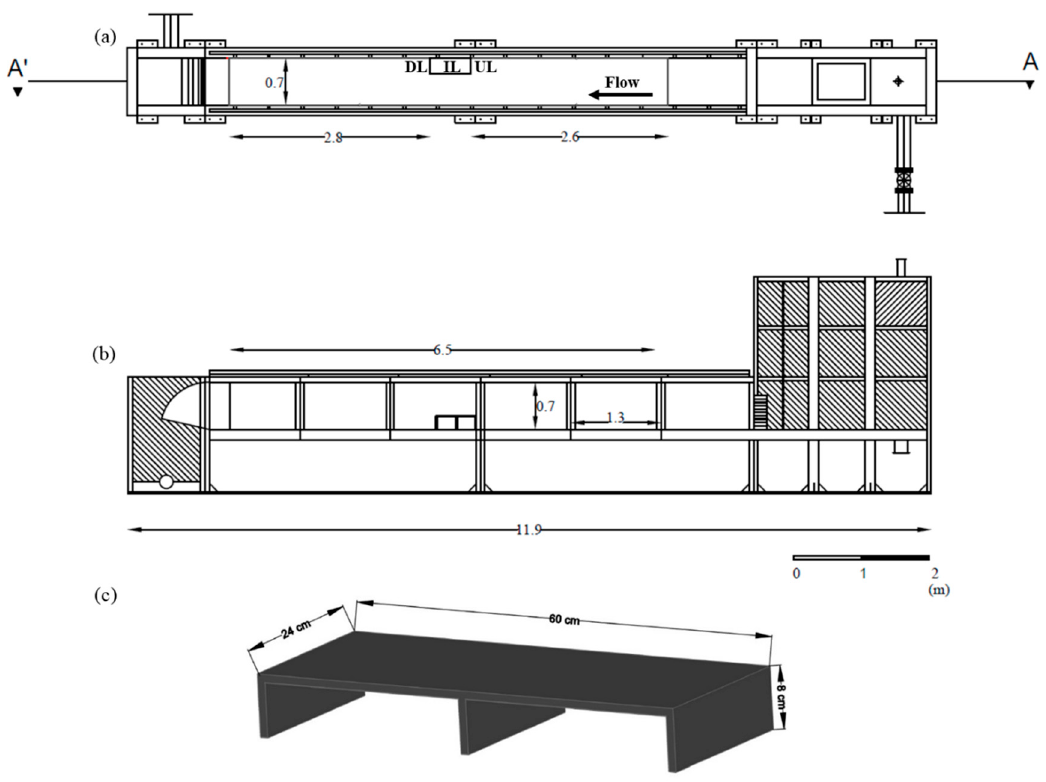
Figure 1. Top ( a ) and lateral ( b ) view of the indoor experimental flume with the dimensions (m), location of the L-structure and correspondent behavior observation areas (DL: Downstream L-structure; IL: Inside L-structure; UL: Upstream L-structure); ( c ) L-structure design and dimensions (cm).